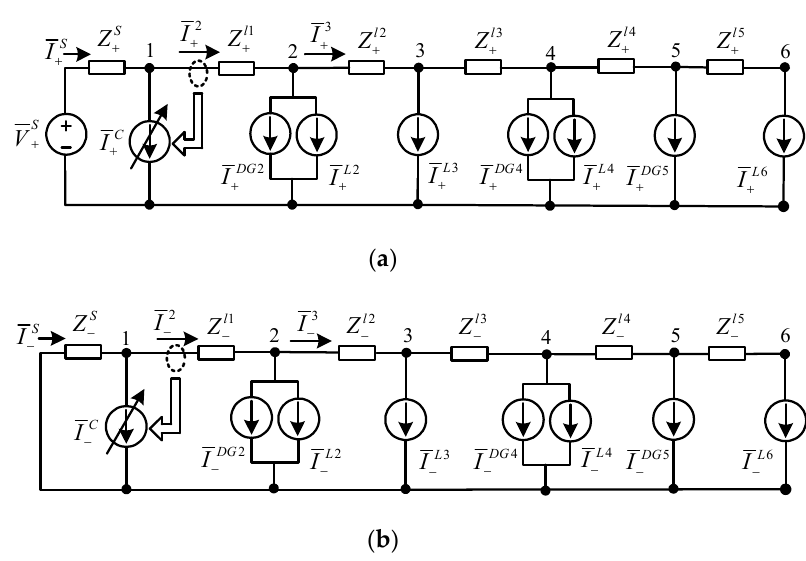
Figure 6. Sequence networks of Figure 1 with the proposed compensator installed at Bus 1. ( a ) Positive-sequence network; ( b ) negative-sequence network.